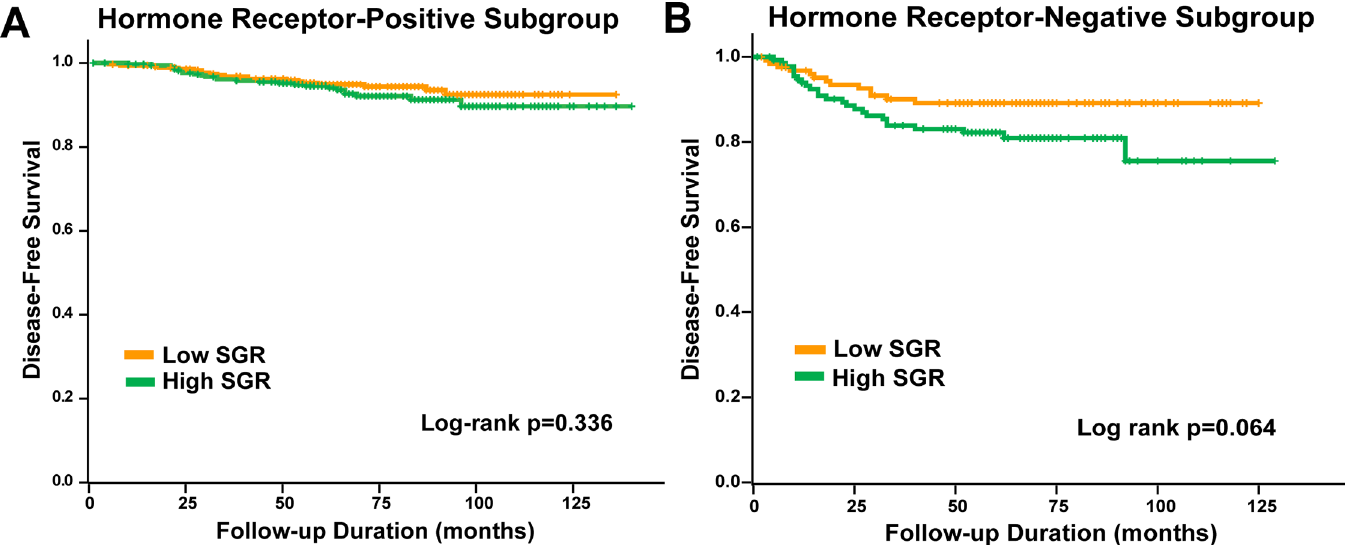
Fig 2. DFS by hormone-receptor status. (A) DFS according to low and high SGR in hormone receptor-positive subgroup (log rank test p = 0.336). (B) DFS according to low and high SGR in hormone receptor-negative subgroup (log rank test p = 0.064).